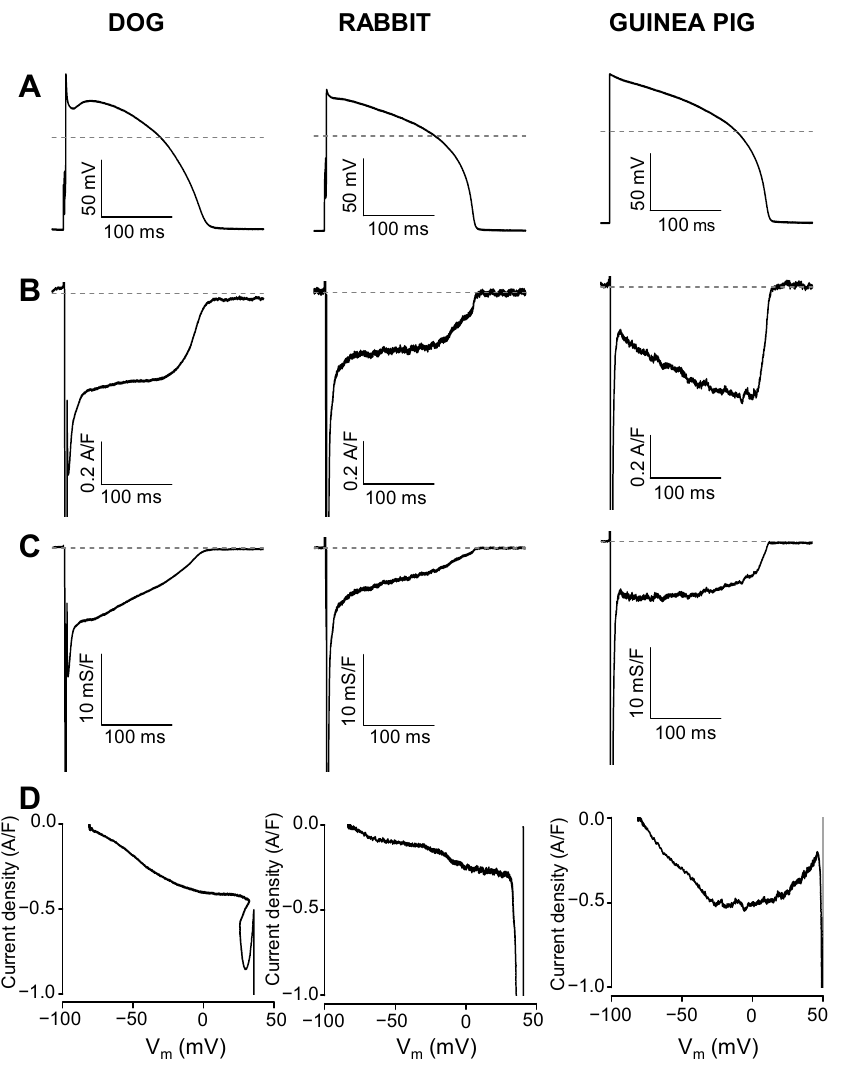
Figure 1. Representative I Na,late ( B ) and G Na,late ( C ) profiles recorded under self APVC conditions from the canine, rabbit, and guinea pig ventricular myocytes. I Na,late was dissected as a 10 µ M TTX-sensitive current using the own AP of the cell as a command signal ( A ). The current–voltage relationships (phase–plane trajectories) are displayed in panel ( D ).